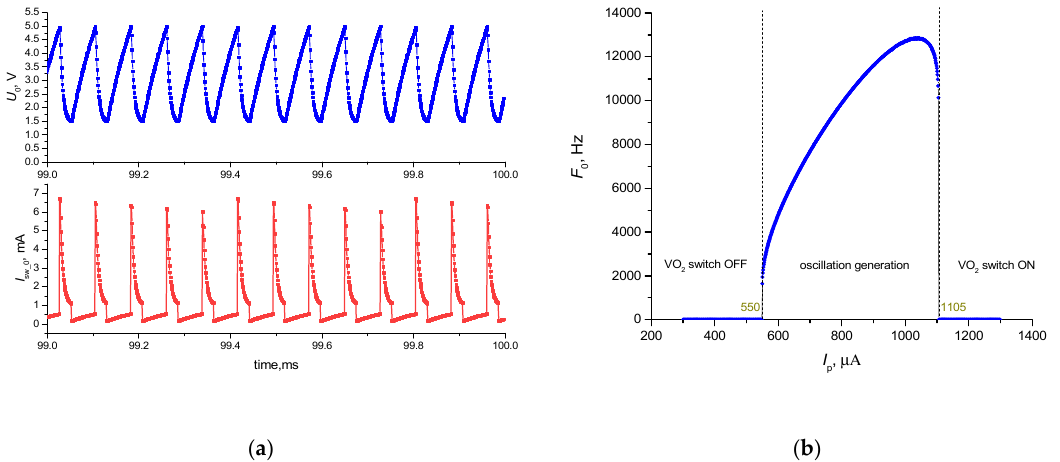
Figure 8. ( a ) Calculated oscillograms sections for the oscillator 0 at I p_0 = 1039 µA, voltage U 0 , and current I sw_0 . ( b ) Dependence of the single oscillator’s own oscillation frequency on the supply current.